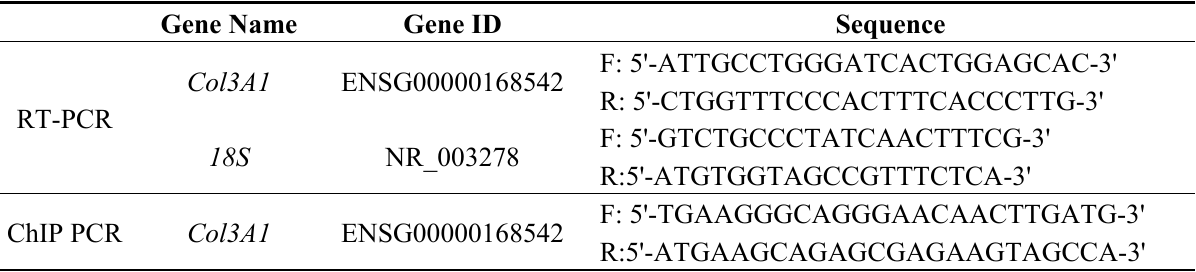
Table 1. PCR primers used in this